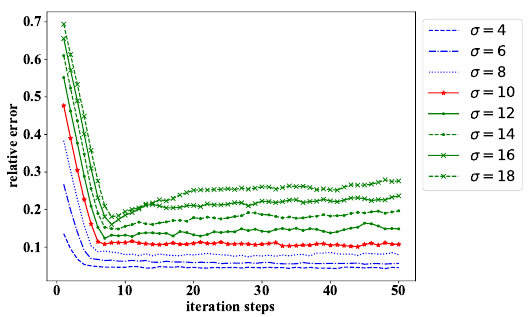
Figure 10. The relative error of each conductivity when SNR = 20